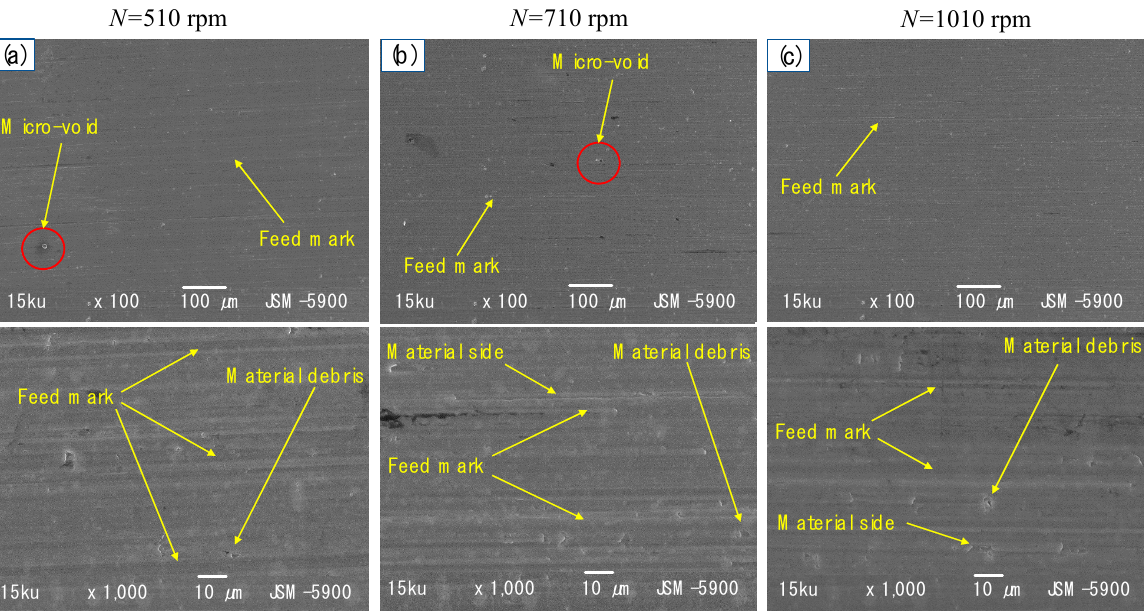
Figure 6. Micro-image of machined surface for spindle speeds of ( a ) 510, ( b ) 710 and ( c ) 1010 rpm at 100× and 1000× magnifications (SEM) with a combination of cutting parameters r 1 and 0.052 mm/rev.